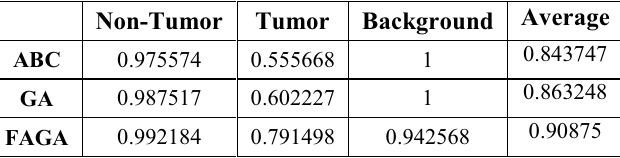
Table 2. Performance comparison using first image in terms of accuracy